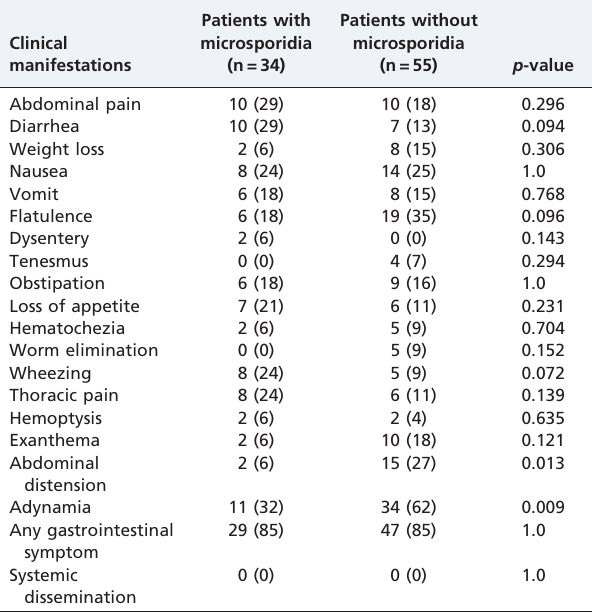
Table 3 - Clinical manifestations in patients with rheumatic diseases undergoing anti-TNF and DMARD therapies with and without microsporidia